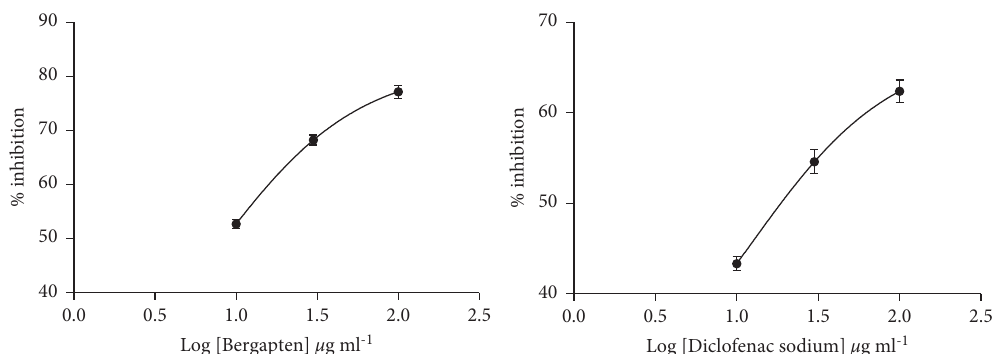
Figure 1: Dose-response curves for bergapten and diclofenac sodium in hypotonic solution-induced hemolysis. The negative control sample consisted of 0.5 ml HRBC suspension mixed with 4.5ml hypotonic solution alone.